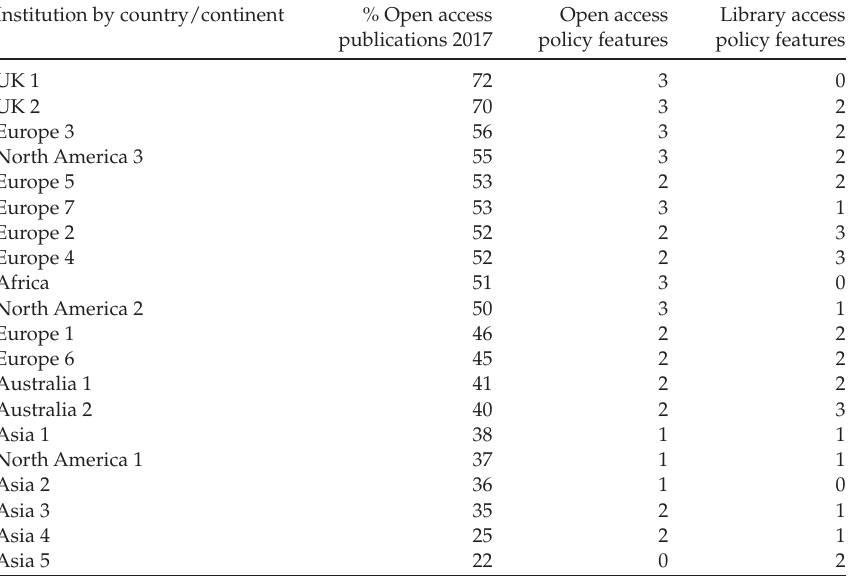
Table 1: Percentage of open access publishing (2017), open access policy features and open library access features scores by